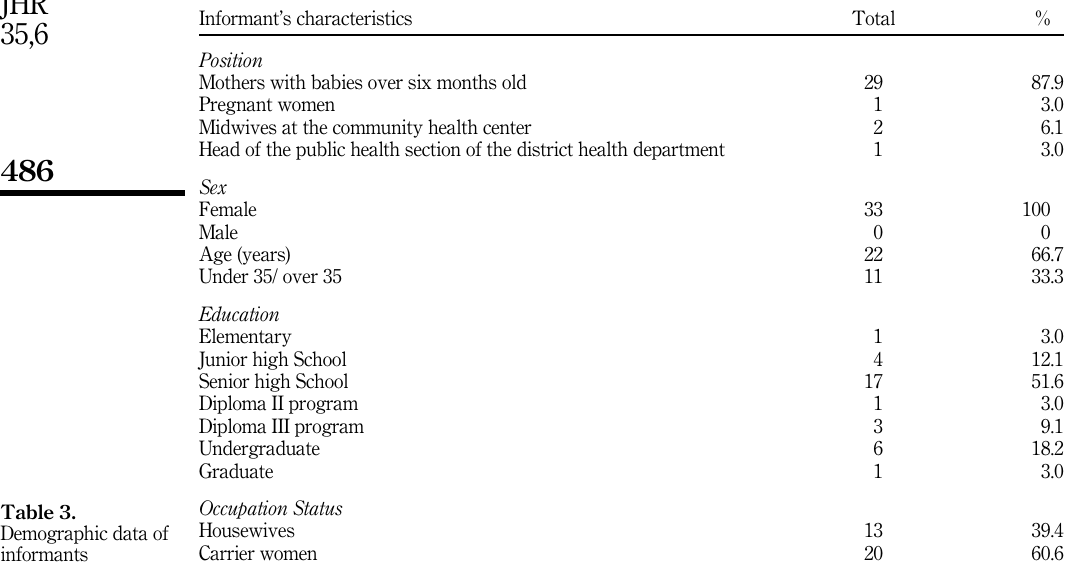
Table 3. Demographic data of